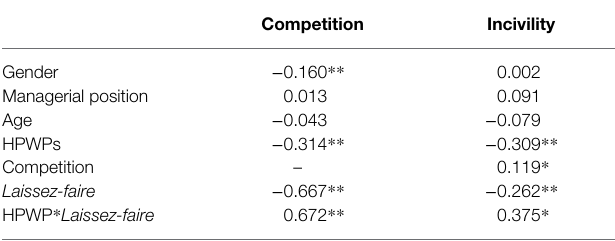
TABLE 2 | Conditional process analysis: standardized regression coefficients after 5,000 bootstraps. Competition